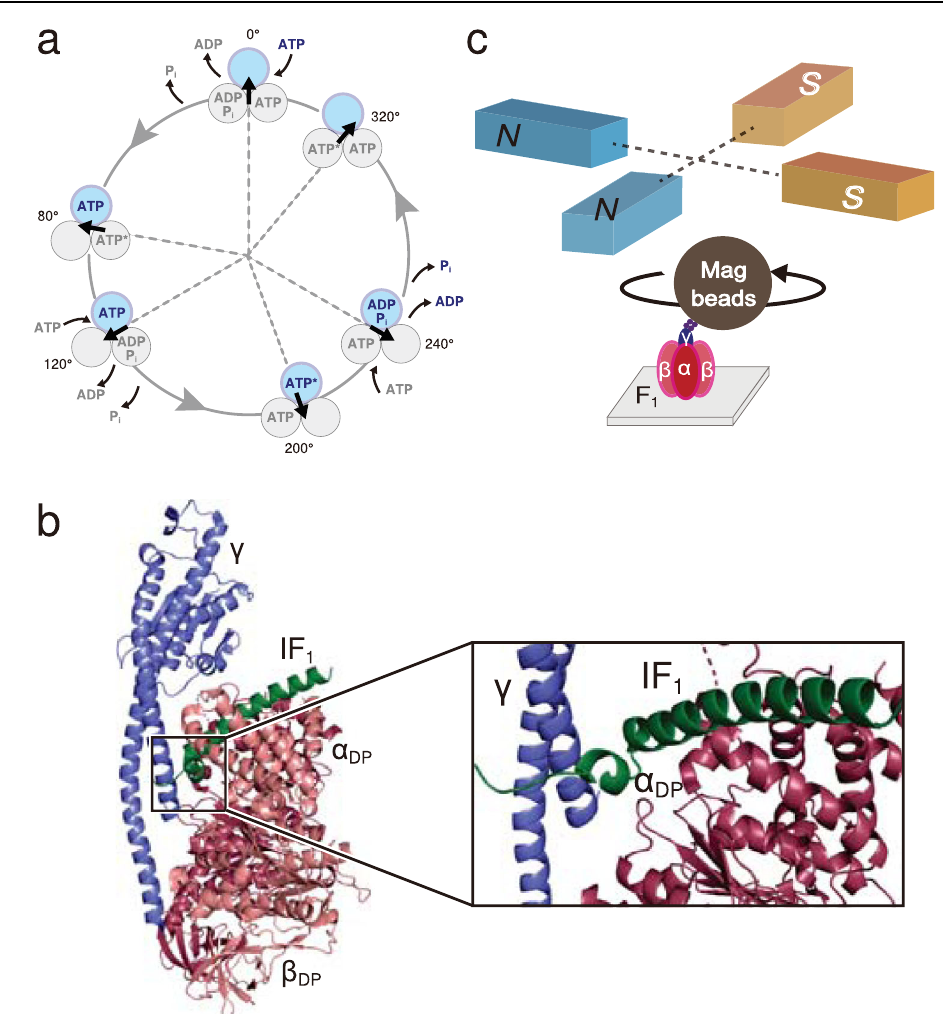
Fig. 1 | Outlineofthis work. a Rotation scheme of b MF 1 . The circles represent the catalytic states of bound nucleotides at the β subunit. ATP* in the circles at 80°, 200°,and320°representsthecatalyticallyactivestateinwhichtheboundATPisto behydrolyzed.Thearrowsrepresenttherotaryanglesof γ subunit.0°isde fi nedas thepositionofthe γ subunitwheretheblue β subunitbindstoATP. Shortpauses at 10°-20°, 130°-140°, and 250°-260°, observed in our previous paper 20 , are omitted from this fi gure for clarity. b Crystal structure of b MF 1 with IF 1 bound to the αβ DP